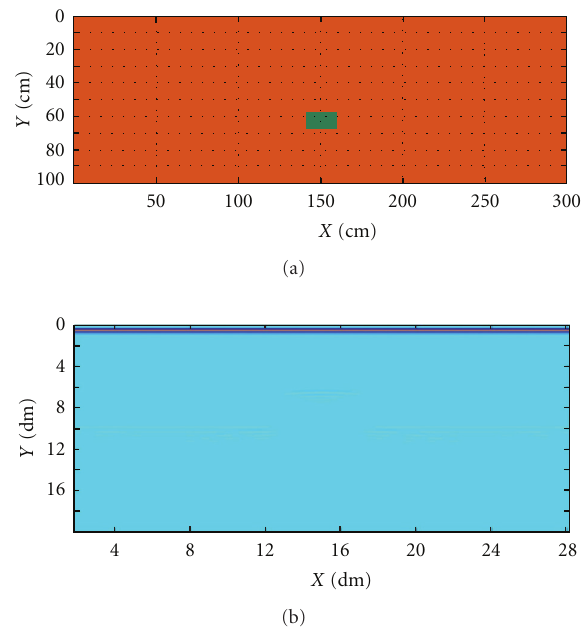
Figure 2: (a) PEC scatterer located within the wall, (b) correspond- ing